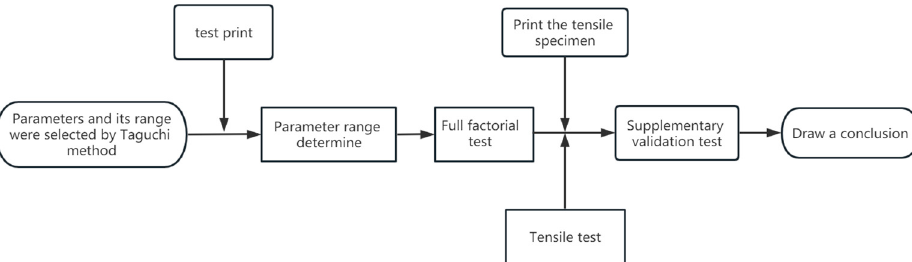
Figure 2. Reinforced fiber layer placement diagram with layer thickness of 0.2 mm, 0.125 mm, 0.05 mm.